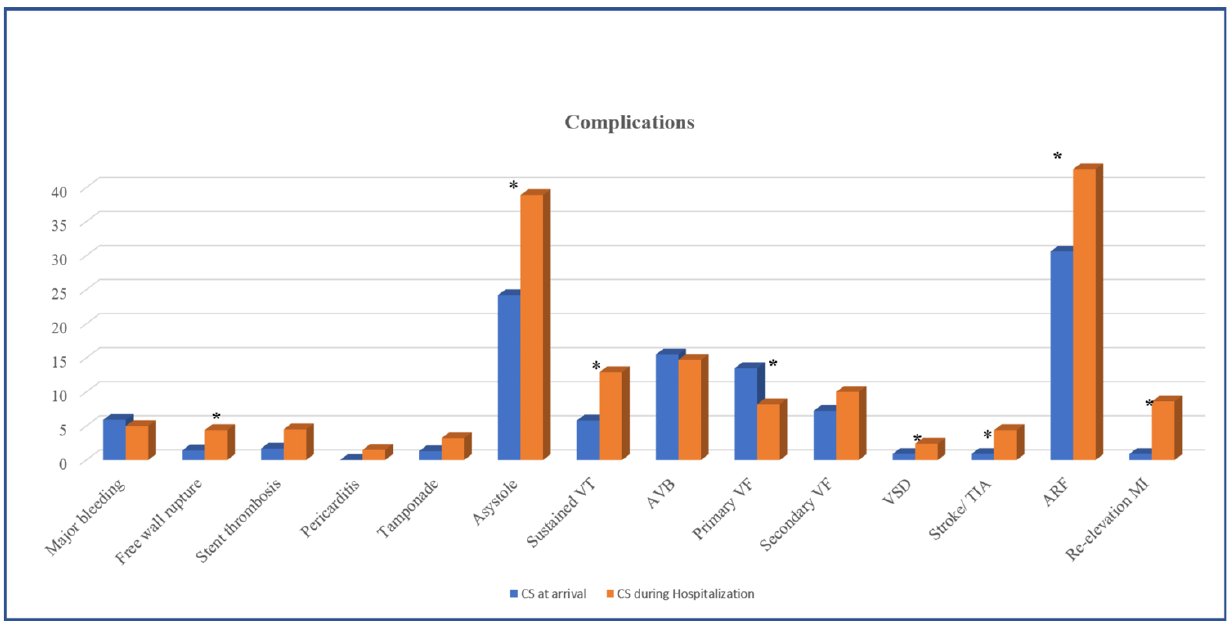
Figure 1. Complications among patients with ACS and CS at arrival versus patients who developed CS during hospitalization. * p < 0.05.